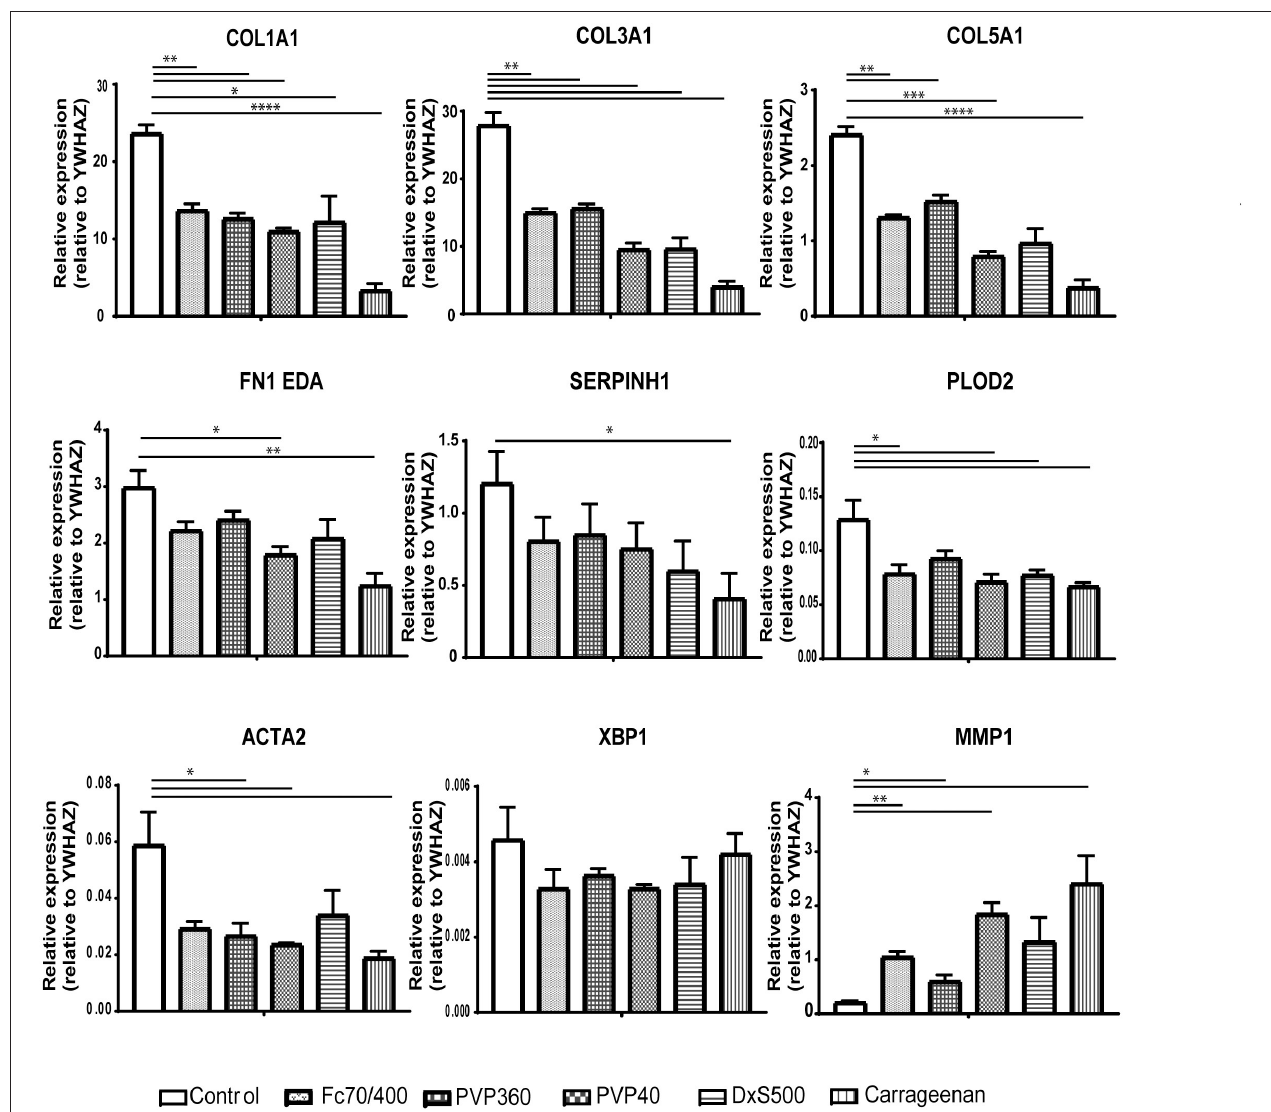
FIGURE 6 | Relative mRNA expression of fibrosis markers in dermal fibroblasts ( n = 4) after 48h of culture. mRNA expression of COL1A1, COL3A1, COL5A1, FN1EDA, SERPINH1, PLOD2, ACTA2, XBP1, and MMP1 in human dermal fibroblasts after 48h without stimulation with TGF β 1, cultured with macromolecular crowders Fc70/400 mixture, PVP360, PVP40, DxS500, and CR vs. control. * = P ≤ 0.05; ** = P ≤ 0.01; *** = P ≤ 0.001; **** = P ≤